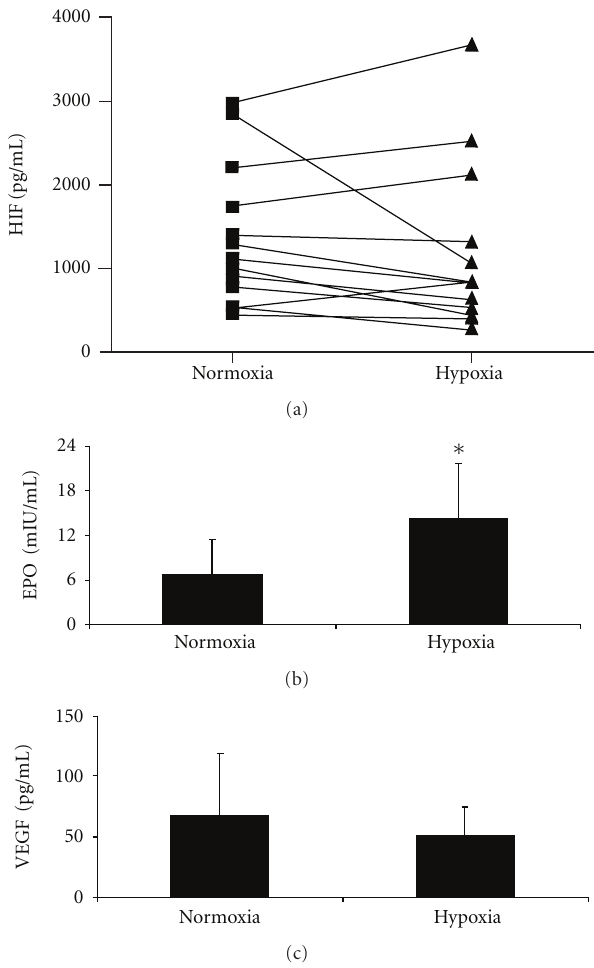
Figure 4: PlasmaHIF, serum EPO, and VEGF concentrationsunder normoxia and hypoxia. n = 14, data are expressed as mean ± SD. ∗ P < . 05.